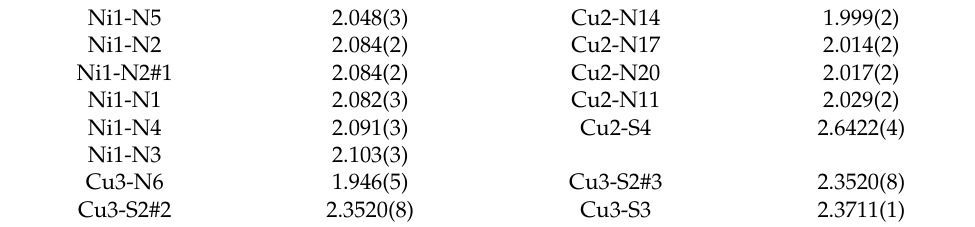
Figure 3. The structure of [{Cu II (trien)} 2 Ni(NCS) 6 Cu I (NCS)] n ( 2 ) with thermal ellipsoids at the level of 30% probability. Hydrogen atoms are omitted for clarity. Table 3. Selected bond lengths [Å] for 2